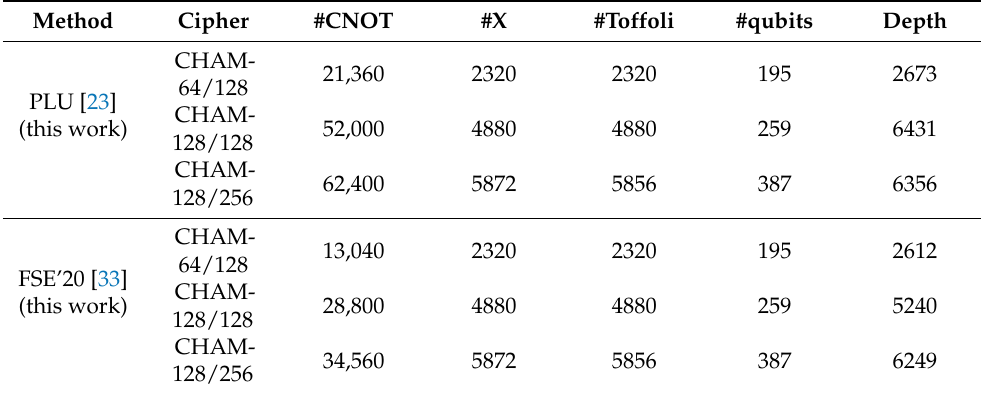
Table 3. Quantum resources required for proposed CHAM implementations.